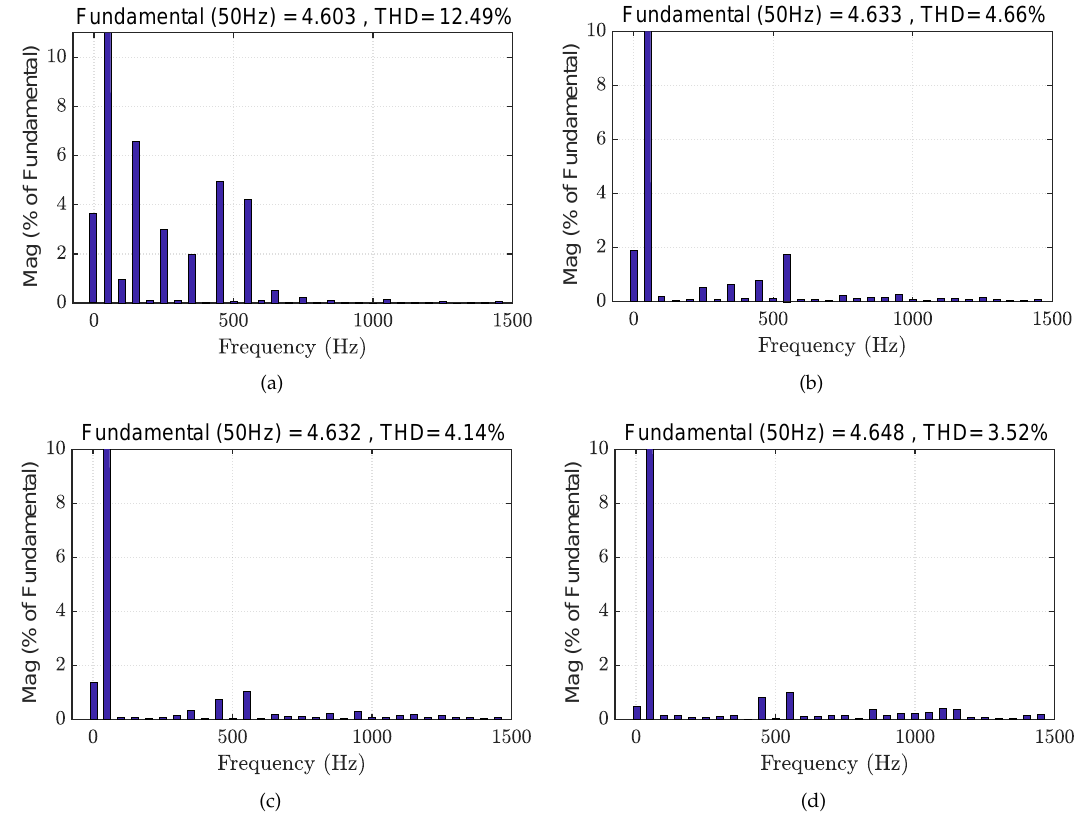
Figure 15. Harmonic distributions of the grid currents: ( a ) Traditional controllers without additional compensation schemes; ( b ) The conventional compensation scheme based on MRSCs; ( c ) The conventional compensation scheme based on the plug-in RC; ( d ) The proposed dual-loop